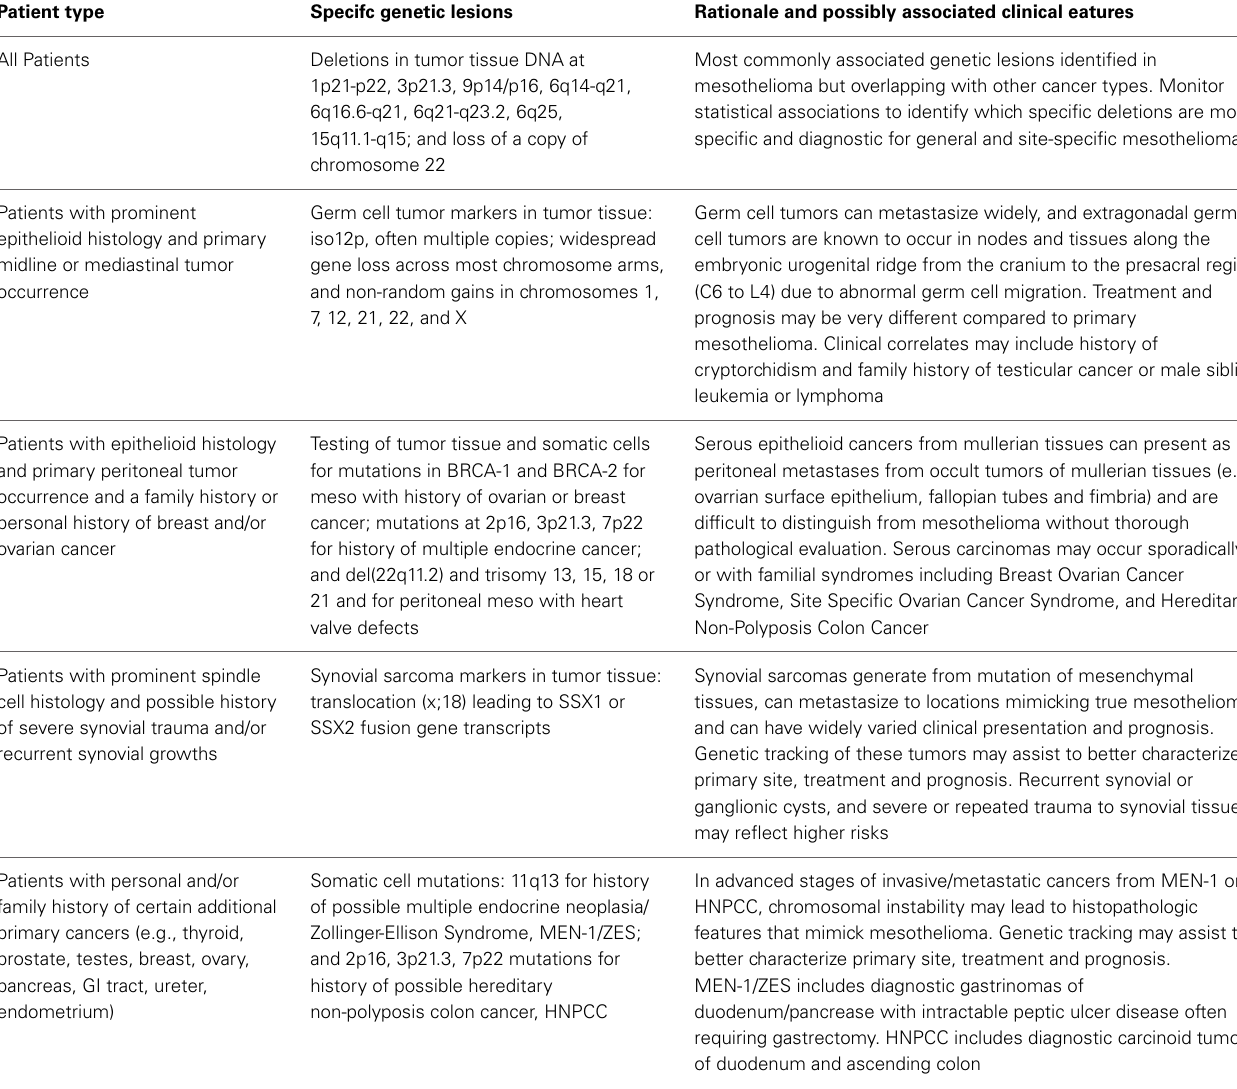
Table 1 | Suggested matrix for genetic screening of suspected malignant mesothelioma